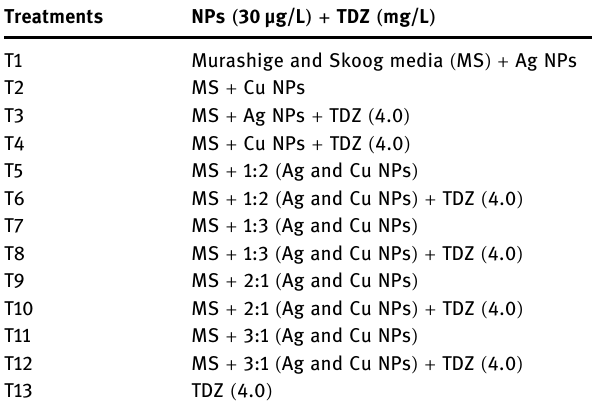
Table 1: Treatment layout